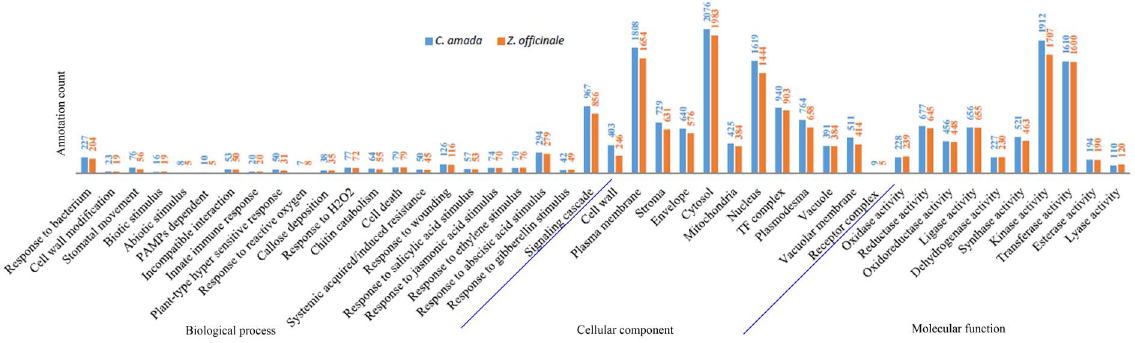
Figure 3. Histogram presentation of Gene Ontology classification of assembled contigs. The results are summarized in three main categories: biological process, cellular component and molecular function. The y-axis indicates the number of genes in a category.